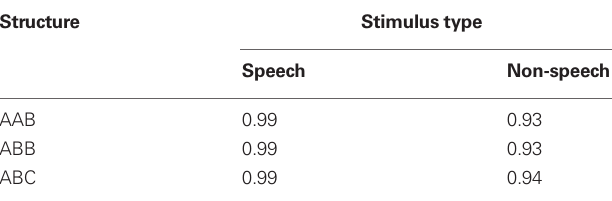
Table 3 | Mean response accuracy (proportion correct) in experiment